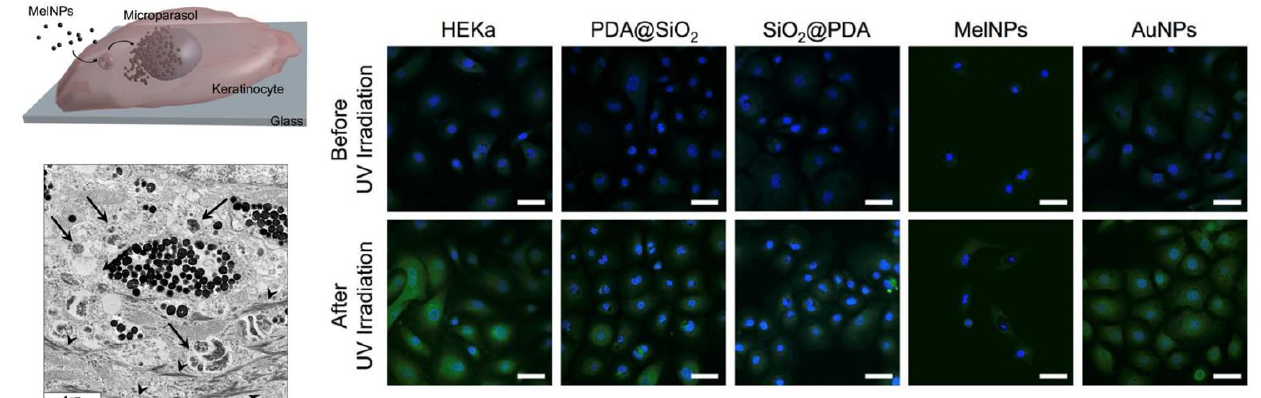
Figure 3. MelNPs uptake scheme and TEM image of HEKa cells with MelNPs after 3 days incubation: black arrows indicate melanosomes and black arrowheads indicate keratin fibers. Confocal imaging of ROS detection in HEKa cells with MelNPs, SiO 2 @PDA core–shell NP, PDA@SiO 2 core–shell NP, and AuNPs after incubation for 3 days. Data are shown before and after 5 min of UV irradiation of these cells. The nuclei were stained with NucBlue (blue); ROS generated in HEKa cells were detected with DCFH-DA (green). Scale bars are 50 µ m. Reprinted with permission from ref.